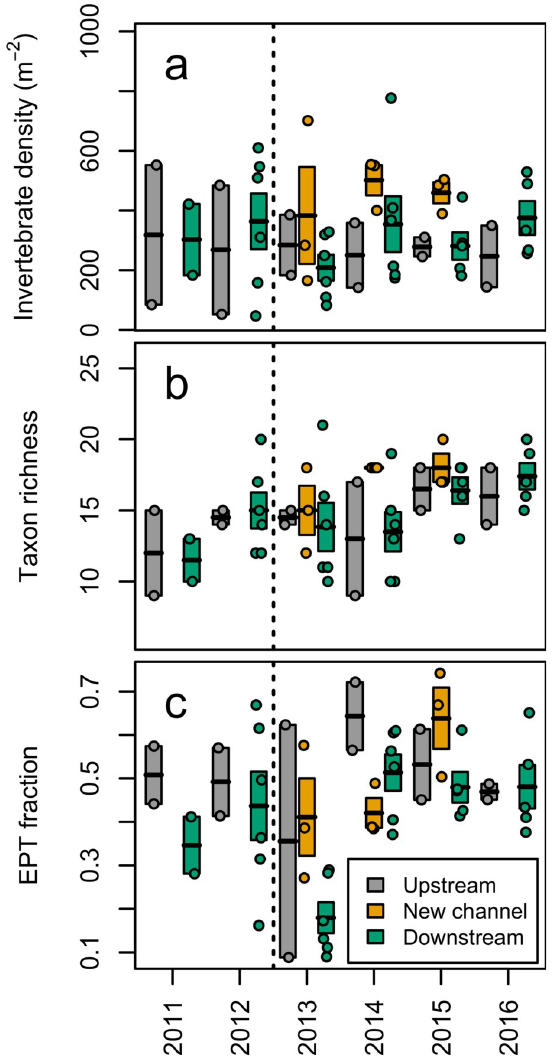
Fig 2. Benthic macroinvertebrate data, summed from six Surber samples (0.093 m 2 ) at each of 11 sites, and averaged at upstream, downstream, and formerly impounded (new channel) sites of the Brown Bridge Dam (removed in between 2012–2013) along the Boardman River, Michigan, USA. Variables measured were: Invertebrates per square meter (A), taxon richness (family level, sometimes higher classification for non-insects) (B) and fraction of insects in orders Ephemeroptera, Plecoptera, and Trichoptera (%EPT) (C). Rectangles show mean +/- SE with mean dividing each rectangle. Points indicate measured values. Dashed line indicates time of dam removal. Due to large numbers of New Zealand mud snails ( Potamopyrgus antipodarum ) at all sites in later years, this taxon was excluded from summary variable calculations. (IndVal = 0.648, p = 0.0024) (Table 4 and Fig 4). New channel sites had a variety of significant indicator taxa including Chironomidae and Gordiidae (IndVal = 0.576 & 0.722, p = 0.0002 (both), respectively), and Perlodidae, Lepidostomatidae, Baetidae, and Ceratopogonidae (IndVal = 0.642, 0.631, 0.573, and 0.583; p = 0.0034, 0.0044, 0.0014, and 0.0152, respectively) (Table 4 and Fig 4). The high number of indicator taxa for new channel sites was consistent with the distinct clustering of these sites from other site categories (Fig 3), providing further indication of distinct macroinvertebrate community composition at these sites.